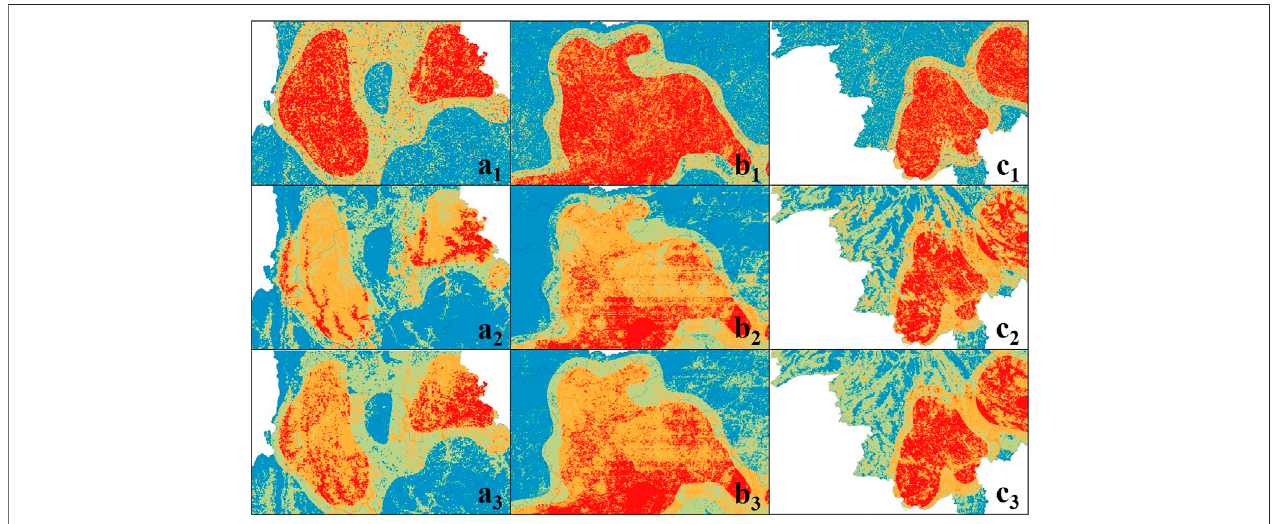
FIGURE 12 | The distribution of wild fi re risk levels in local regions (a, b, and c) .